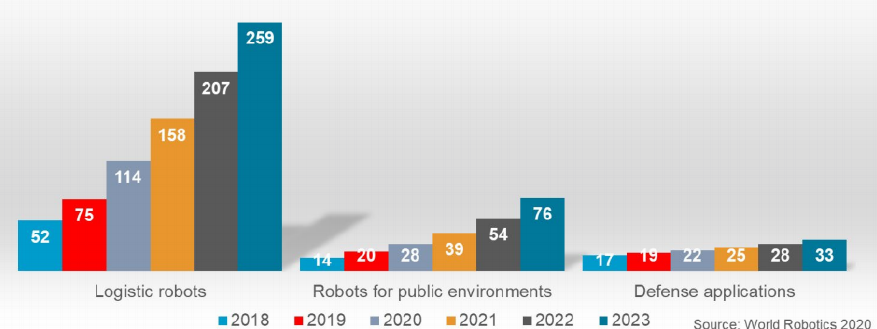
Figure 1. Service robots for professional use. Top 3 applications unit sales 2018 and 2019, potential development 2020–2023 (thousands of units)